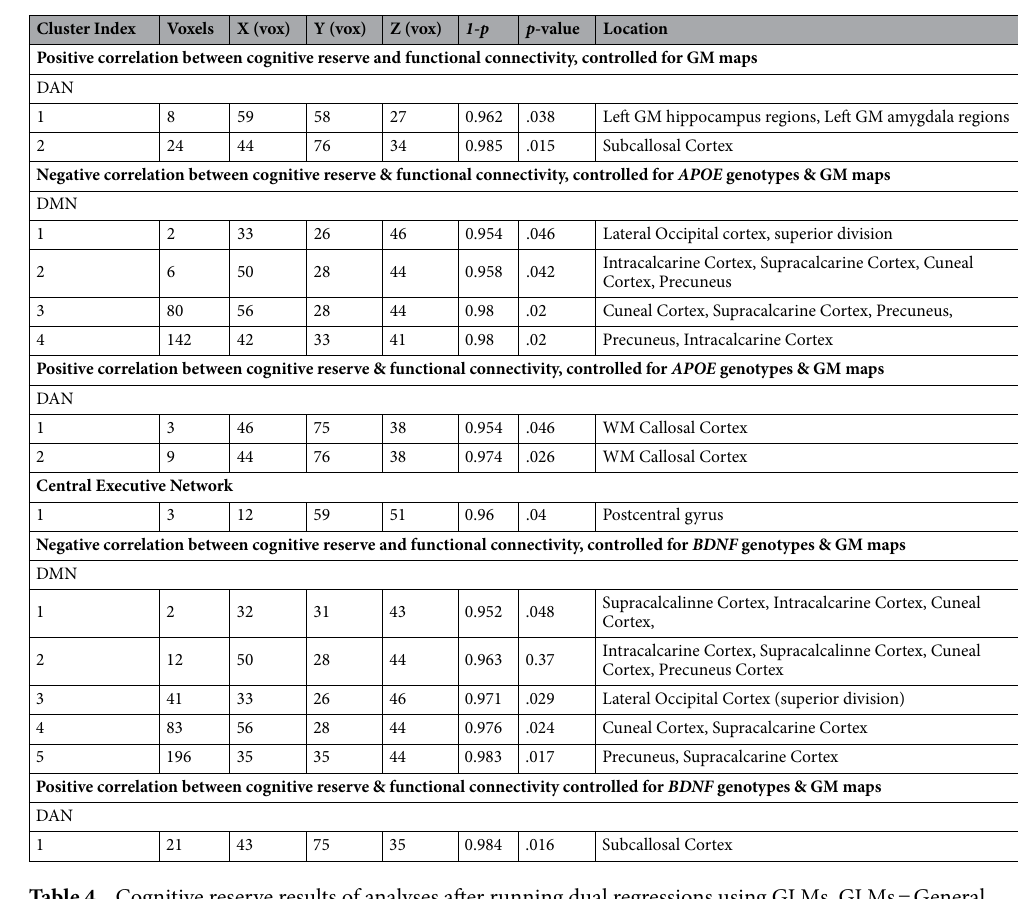
Table 4. Cognitive reserve results of analyses after running dual regressions using GLMs. GLMs = General Linear Models; DMN = Default Mode Network; DAN = Dorsal Attention Network; APOE = Apolipoprotein E; GM = grey matter; BDNF = Brain-derived neurotrophic